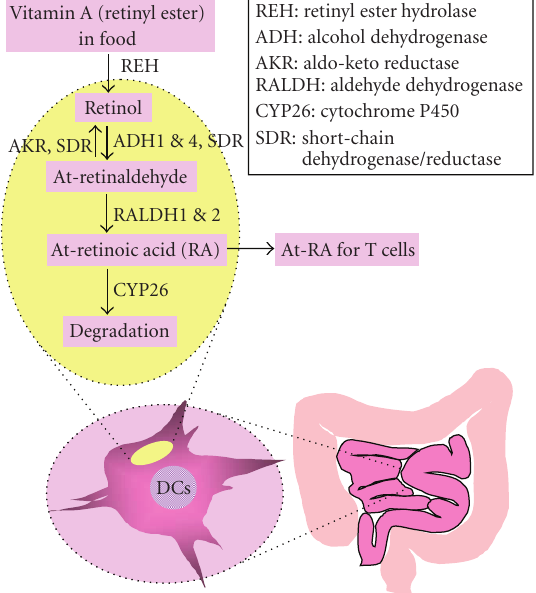
Figure 1: Synthesis of retinoic acid in the dendritic cells of the in- testine. Vitamin A is consumed as retinyl ester and hydrolyzed by retinyl ester hydrolase (REH). Retinol, entered into cells, is oxi- dized to retinaldehyde by alcohol dehydrogenase (ADH) or short- chain dehydrogenase/reductase (SDR). The reverse reaction is me- diated by aldo-keto reductase (AKR) or SDR. Retinaldehyde can be converted to retinoic acid (all-trans retinoic acid or At-RA) by retinaldehyde dehydrogenase (RALDH). Retinoic acid is degraded in cells by cytochrome P450 (CYP26). It is known that dendritic cells in the gut-associated lymphoid tissues (GALT) such as Peyer’s patches and MLN express high levels of ADH1, ADH4, RALDH1, and/or RALDH2. The retinoic acid produced by dendritic cells can be exported for other cells such as T cells during the cognate inter- action between dendritic cells and T